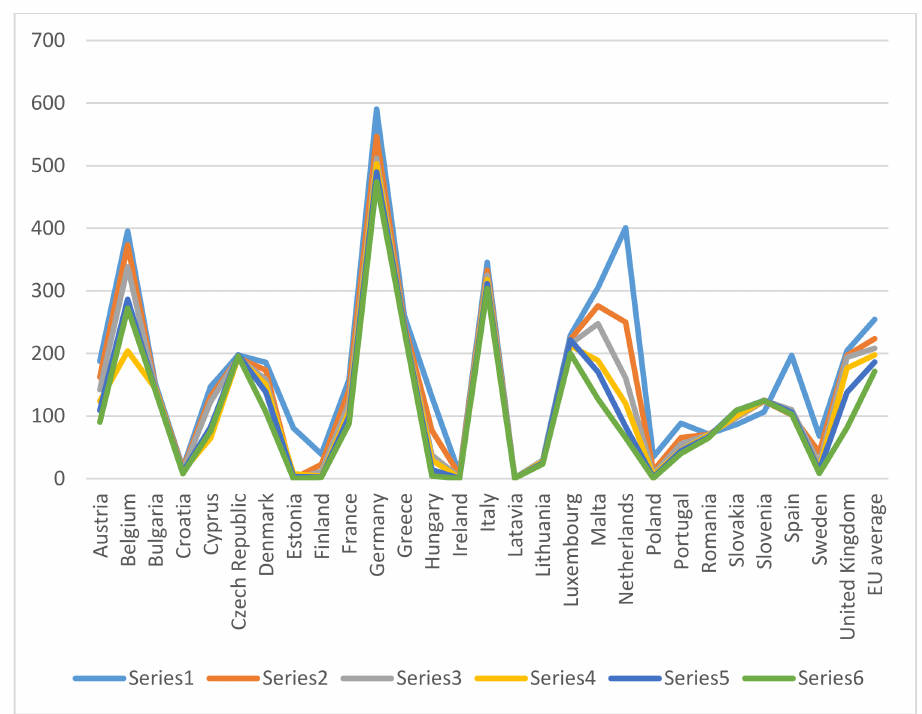
Figure 2. The photovoltaic capacity addictions in EU countries in the years 2014–2019 (MW). Source: Own analyses based on data: [21–27].